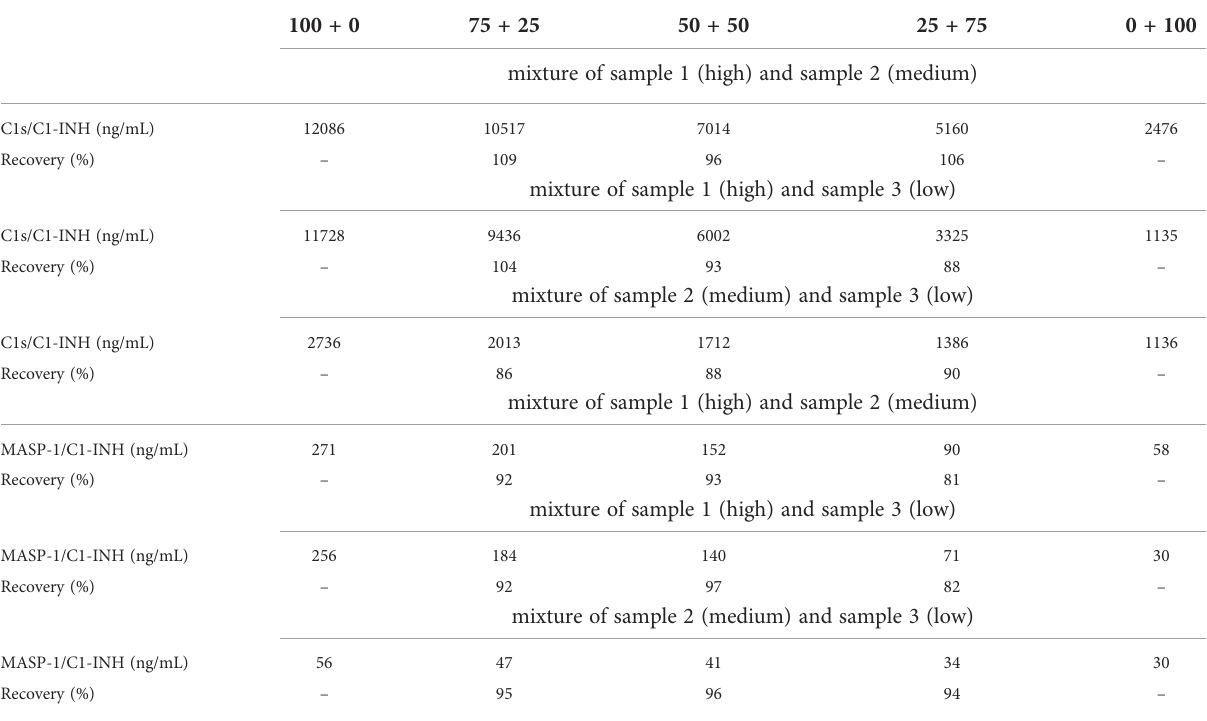
TABLE 3 Recovery of C1s/C1-INH and MASP-1/C1-INH complexes in EDTA plasma.